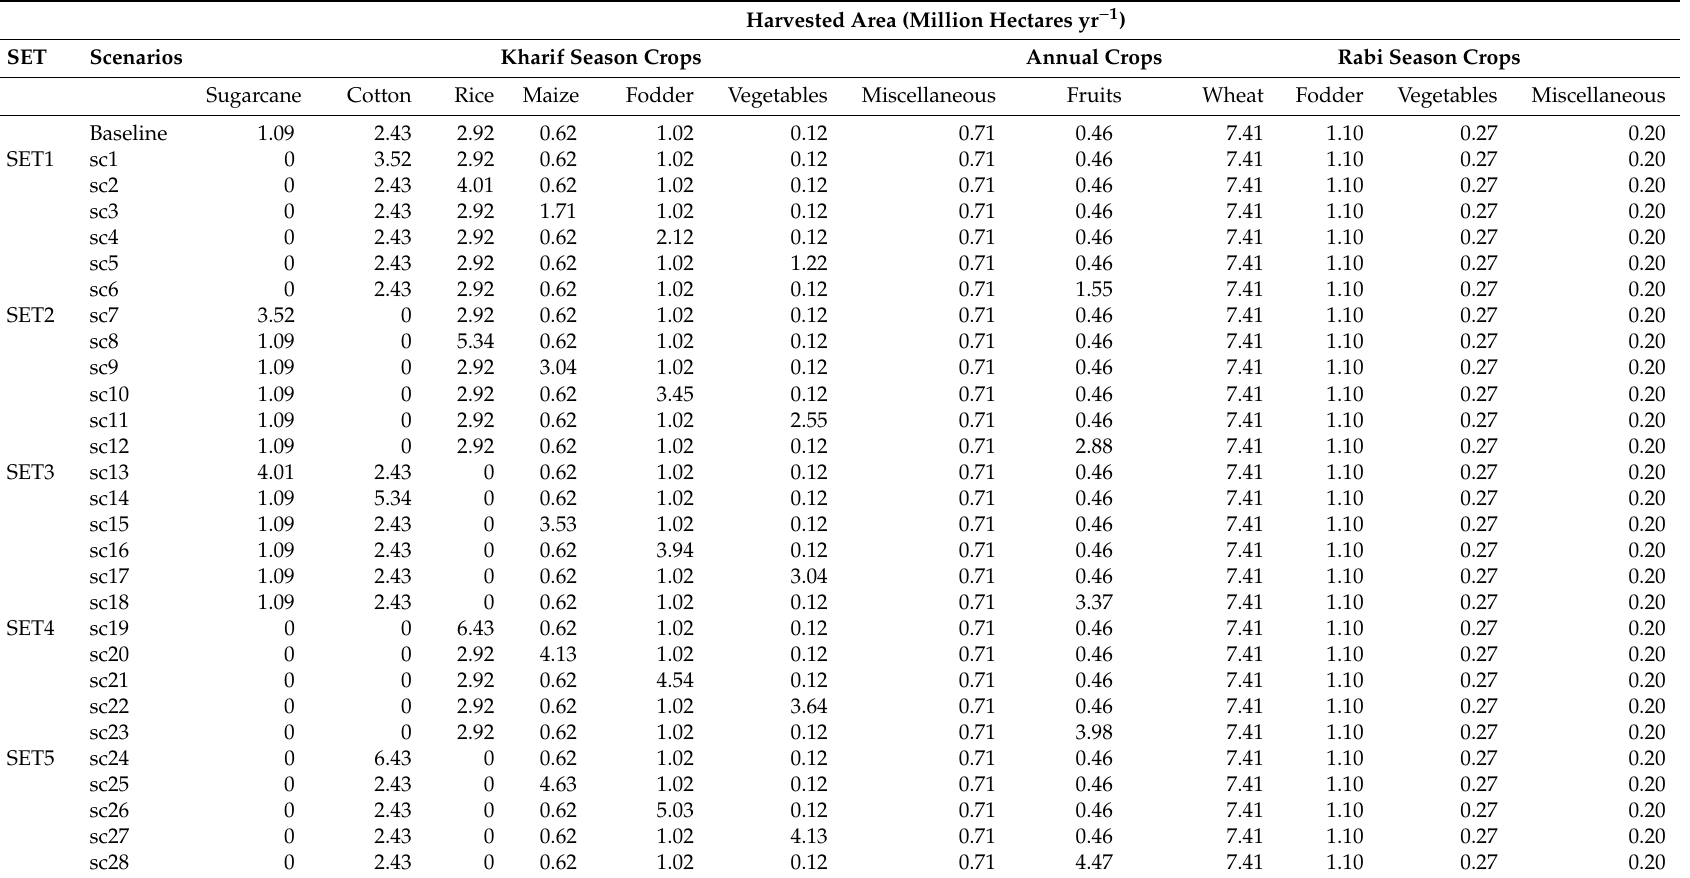
Table A2. Harvest area of the baseline year 2016 and the 37 cropping